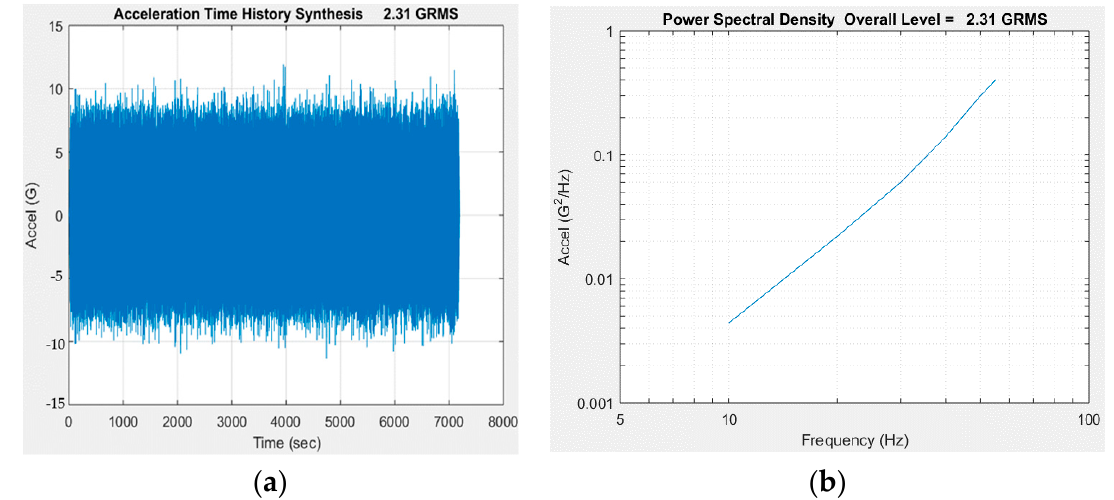
Table 3. Acceleration base input and acceleration response. Figure 6. Base input PSD: ( a ) PSD 2.31 GRMS, ( b ) PSD time history synthesis.